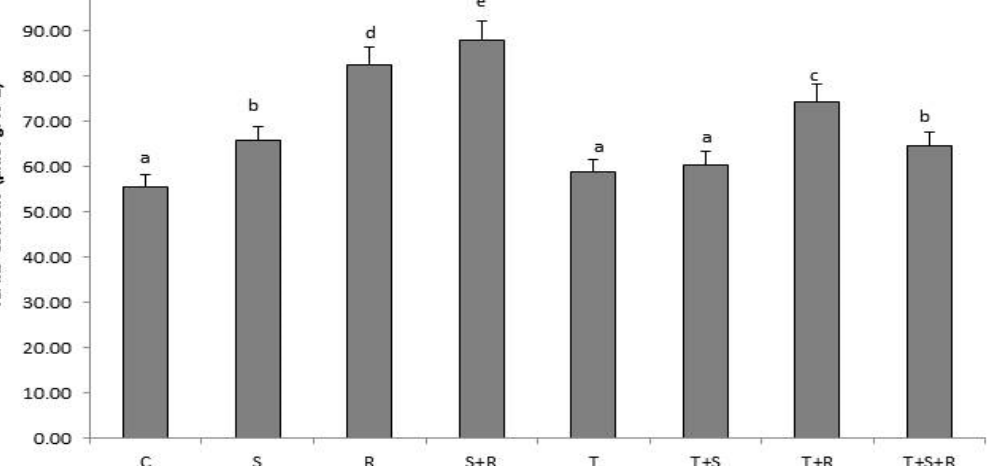
Figure 6. The effect of T. citrinoviride on TBARS content in the leaves of strawberry plants which were subjected to abiotic stress (40 mM NaCl) and biotic stress (R. solani) either separately or in combination. Different letters indicates significant differences between treatments ( p < 0.05). C, control; S, NaCl-treated; R, R. solani -infected; S + R, Salt stress + R. solani; T, T. citrinoviride- treated; T + S, T. citrinoviride + NaCl; T + R, T. citrinoviride + R. solani ; T + S + R, T. citrinoviride + NaCl + R. solani .